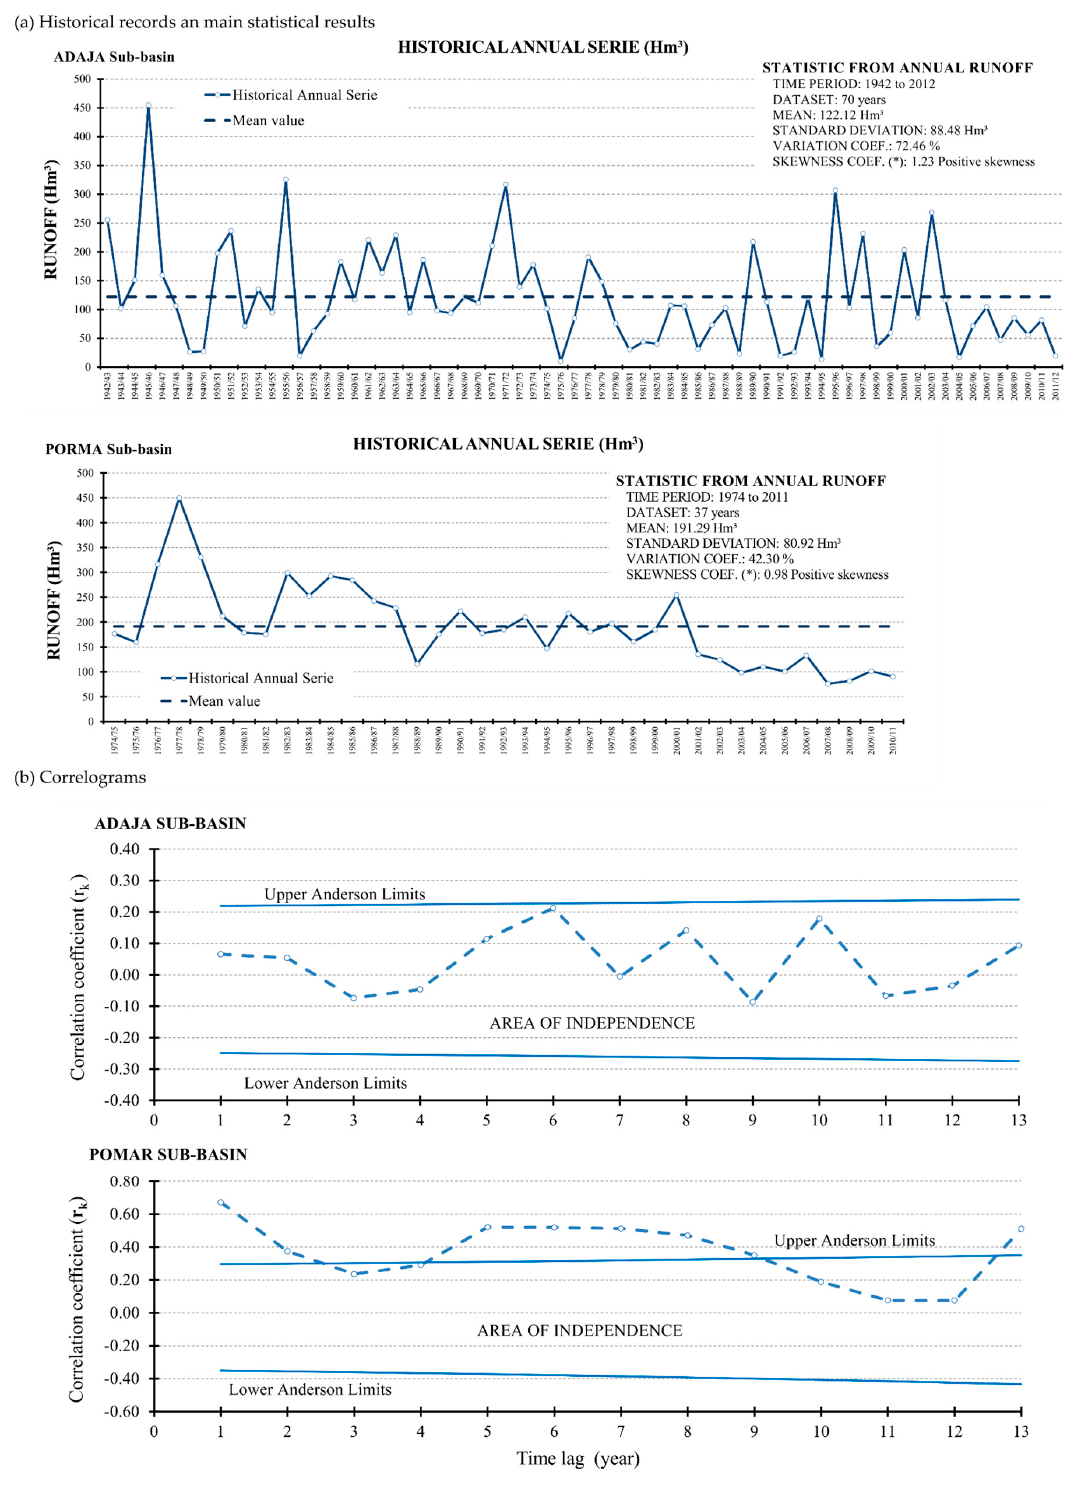
Figure 4. ( a ) Historical records and main statistical result (*) Classic Skewness Coefficient; ( b ) Correlograms that are generated from historical series. Probability limits at the 95% confidence level for an independent variable, according to Anderson limits methodology.